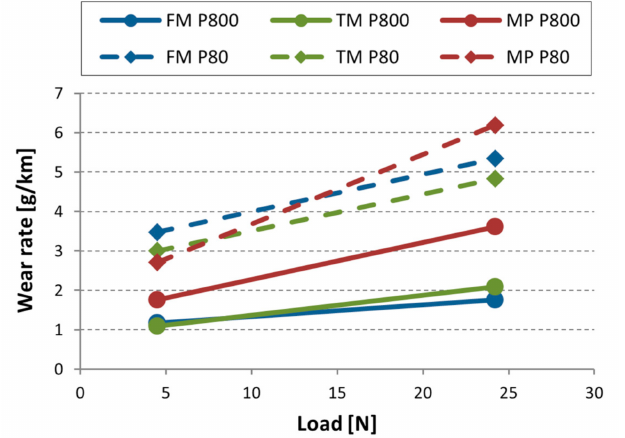
Figure 8. Wear rate (g/km) of tested materials with different abrasive particles (P80, P800) in the function of normal load